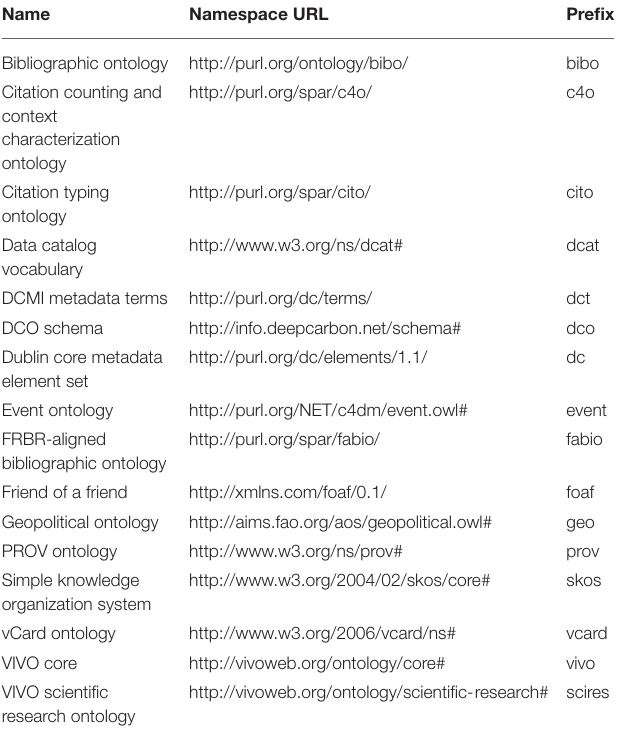
TABLE 1 | Ontologies and schemas used in